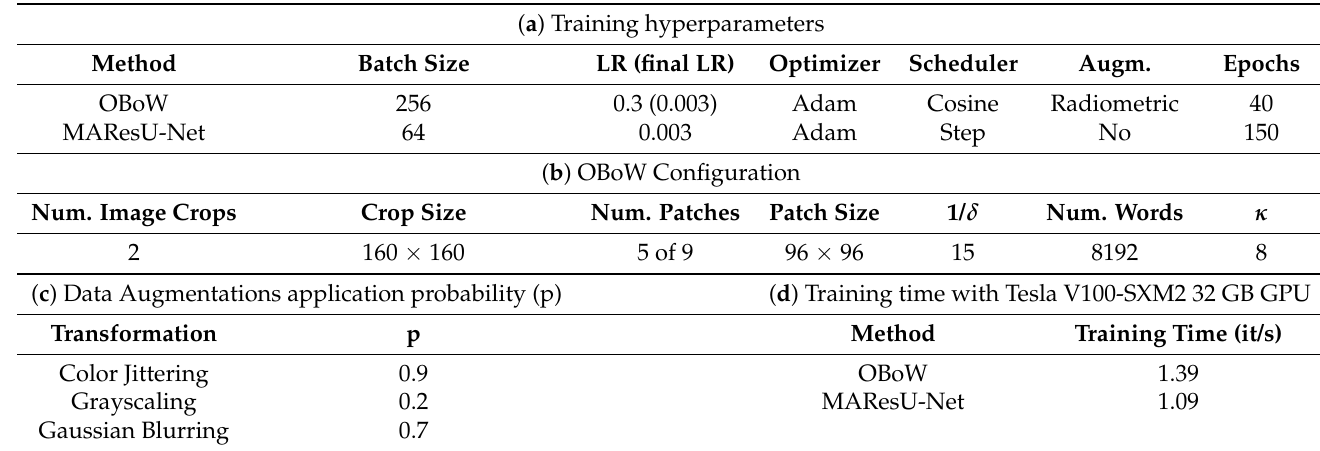
Table 1. Summary of the training process. In ( a ) the principal training hyperparameters of the two methods are shown. Most of them trace the one presented in [12,18]. In ( b , c ) some details about OBoW configuration are offered. In particular, in ( c ) we show the augmentation applied for the training. In ( d ) the training times are shown.